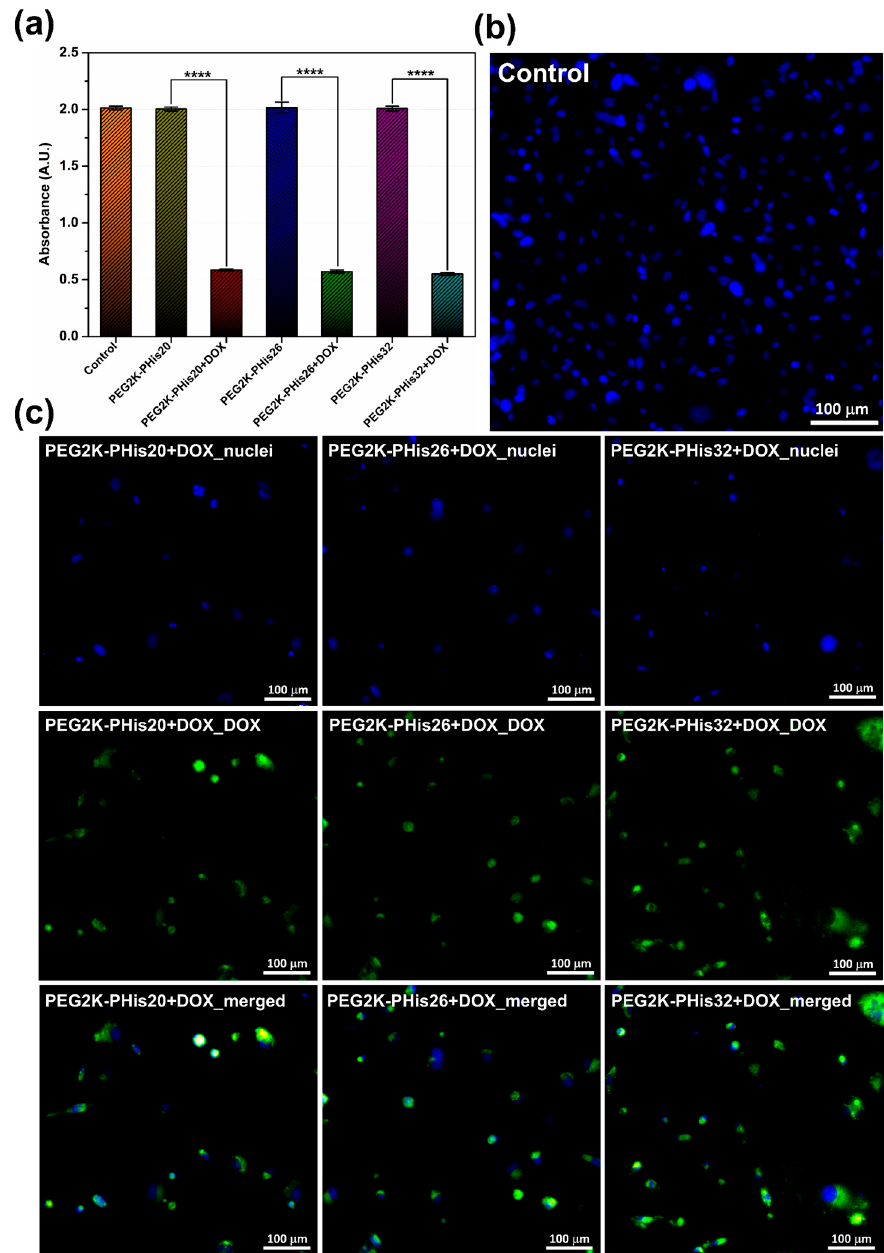
Figure 9. Cell viability and immunofluorescence at 72 h: ( a ) MDA-MB-231 viability at 72 h expressed as absorbance for the control, unloaded micelles, and DOX-loaded micelles; ( b ) immunofluorescence image for the nuclei of MBA-MB-231 cells line used as a control; ( c ) immunofluorescence images for the three types of micelles loaded with DOX; images with the highlighting of cell nuclei, images with the highlighting of DOX-loaded micelles, and the merging of the two images for each sample. **** p < 0.0001. Pictures were acquired at 20× magnification.